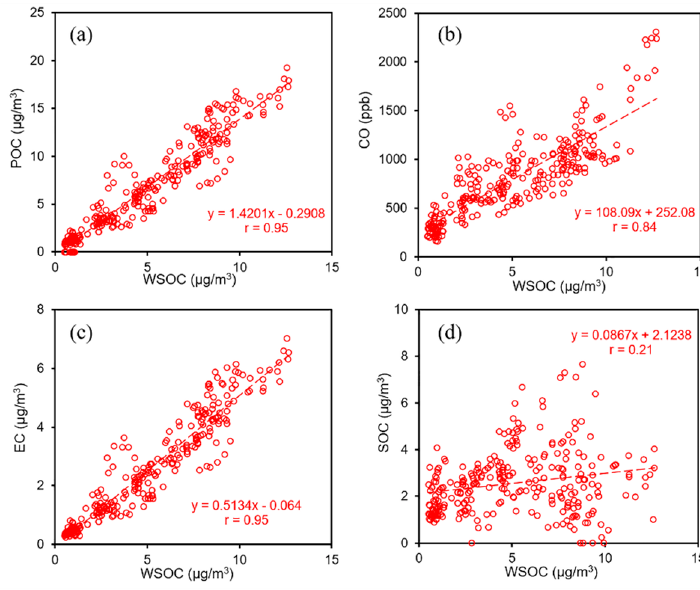
Figure 3. Correlations of WSOC with ( a ) POC, ( b ) CO, ( c ) EC, and ( d ) SOC.